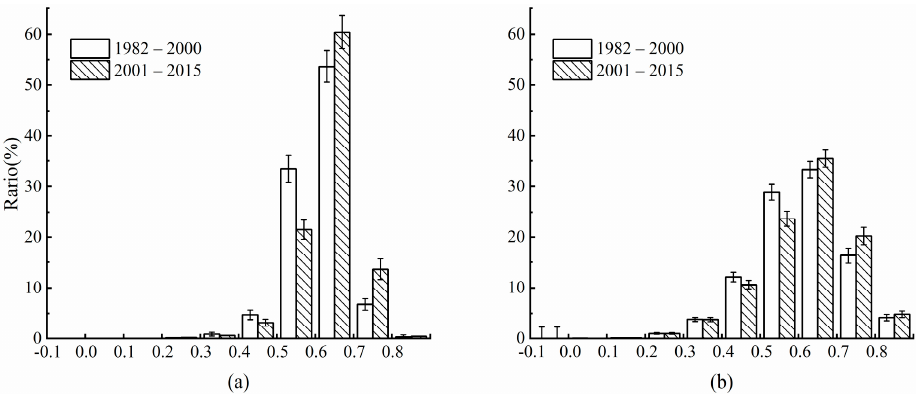
Figure 12. Comparisons of vegetation NDVI before and after the implementation of ecological projects during about 2000 in Southwest China: ( a ) Karst area and ( b ) non-karst area.